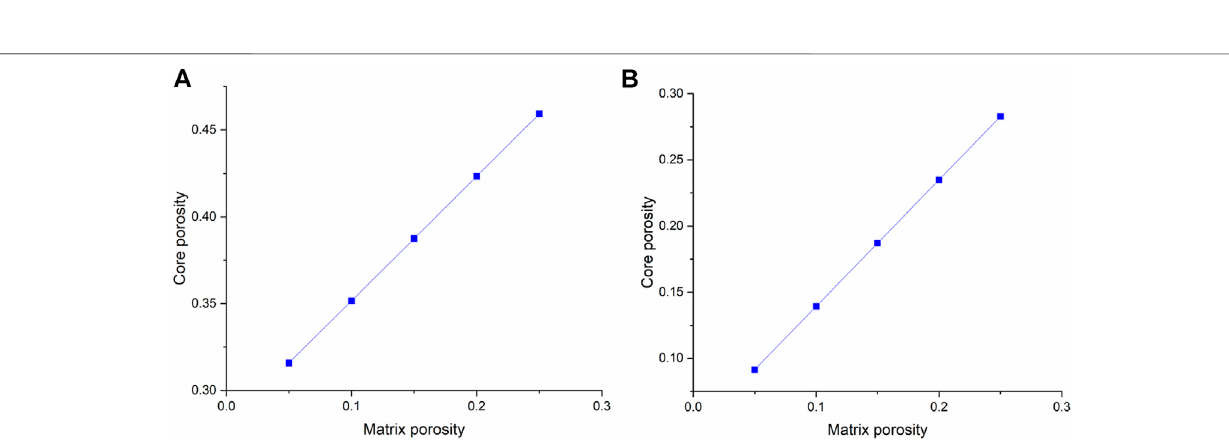
Frontiers in Earth Science |